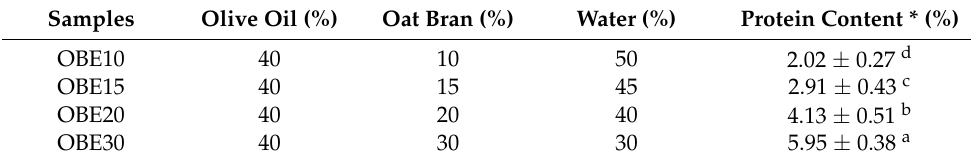
Table 1. Formulation (%) and protein content (%) of different oat bran O/W emulsions. Samples Olive Oil (%)